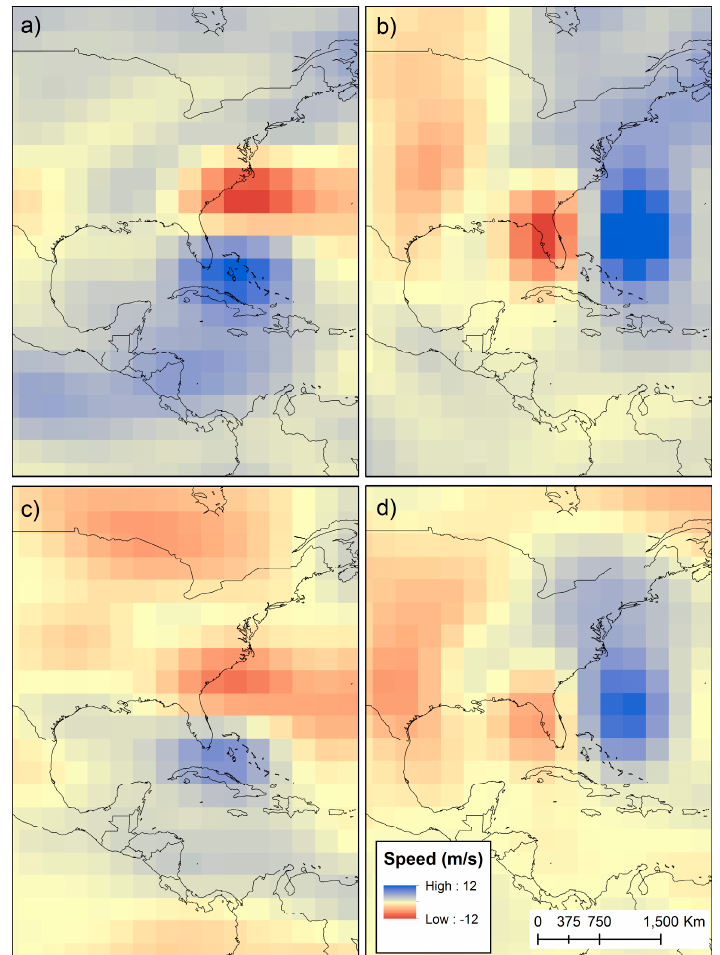
Figure 8. Anomalies of zonal and meridional winds at 850 hPa on the day before TCs entered the study region. ( a ) zonal winds averaged for TCs in Figure 7a, ( b ) meridional winds averaged for TCs in Figure 7a, ( c ) zonal winds averaged for TCs in Figure 7b, and ( d ) meridional winds averaged for TCs in Figure 7b.